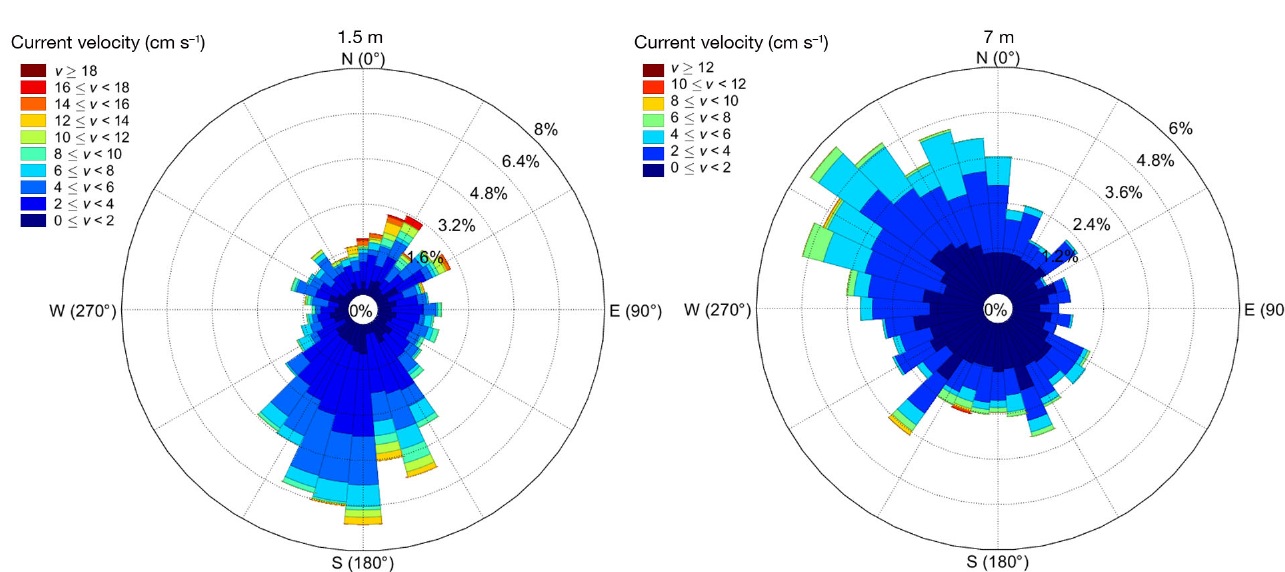
Fig. 5. Measured current velocities ( v) and frequencies of current direction at 1.5 and 7 m depths during the campaign period. Data plotted with Wind Rose package in